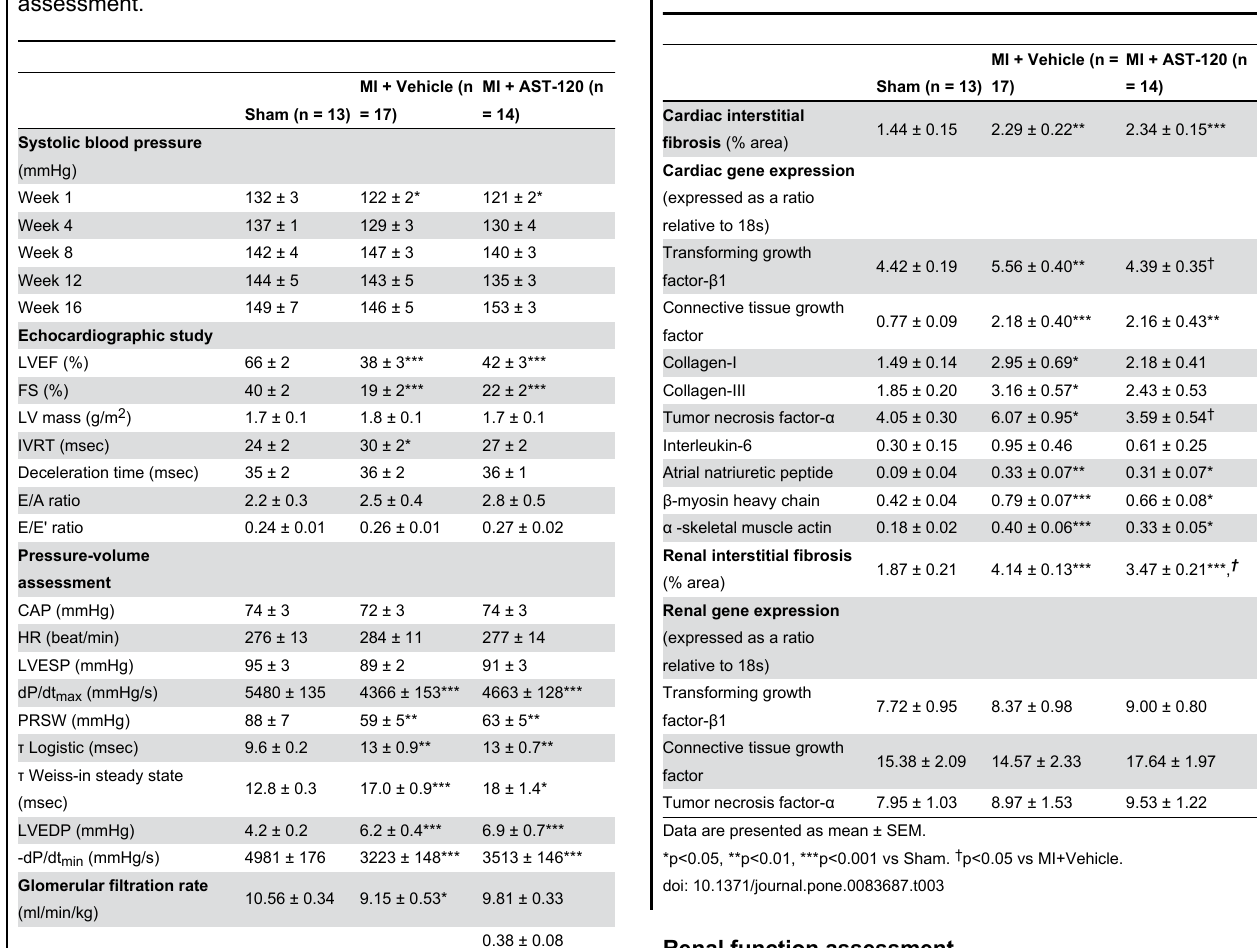
Table 3. Fibrosis and gene expression data.